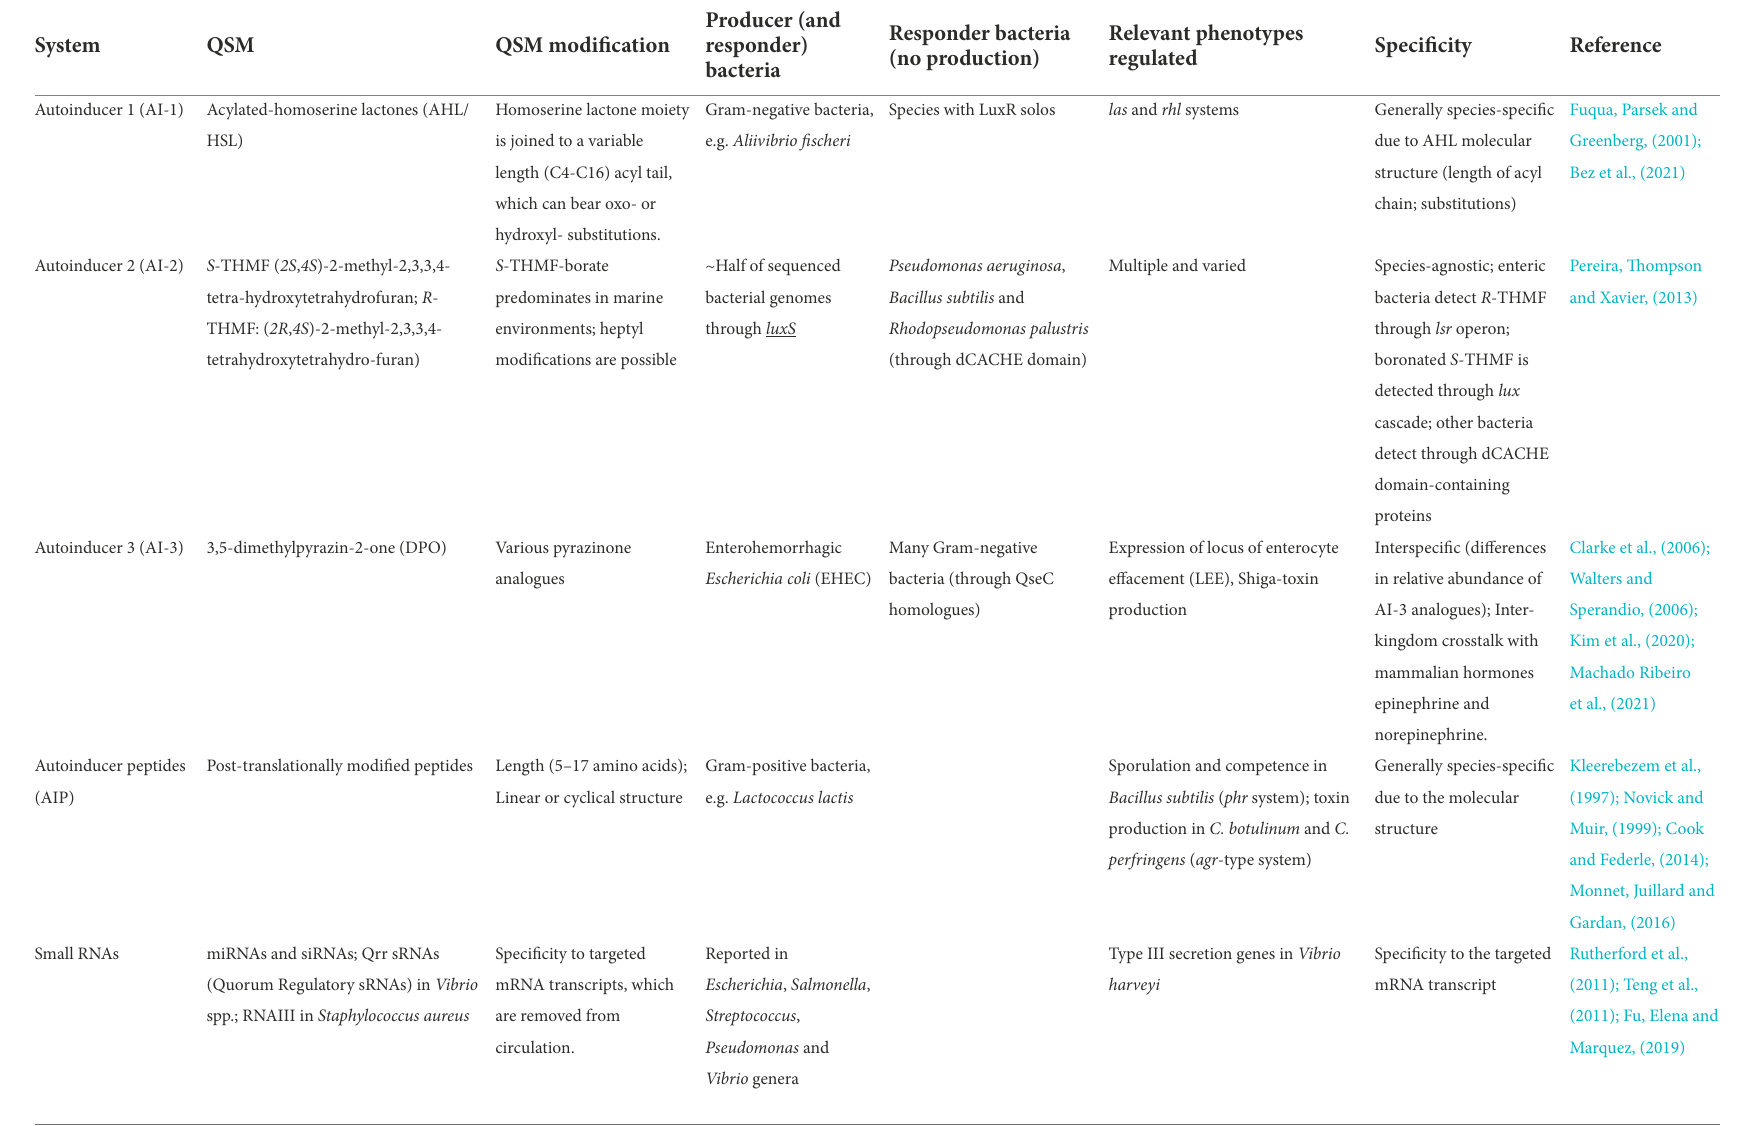
TABLE 1 Overview of major bacterial Quorum Sensing Molecules (QSM) families, examples, possible modifications, producer and/or responder bacteria utilising the QSM as well as the regulated phenotypes and